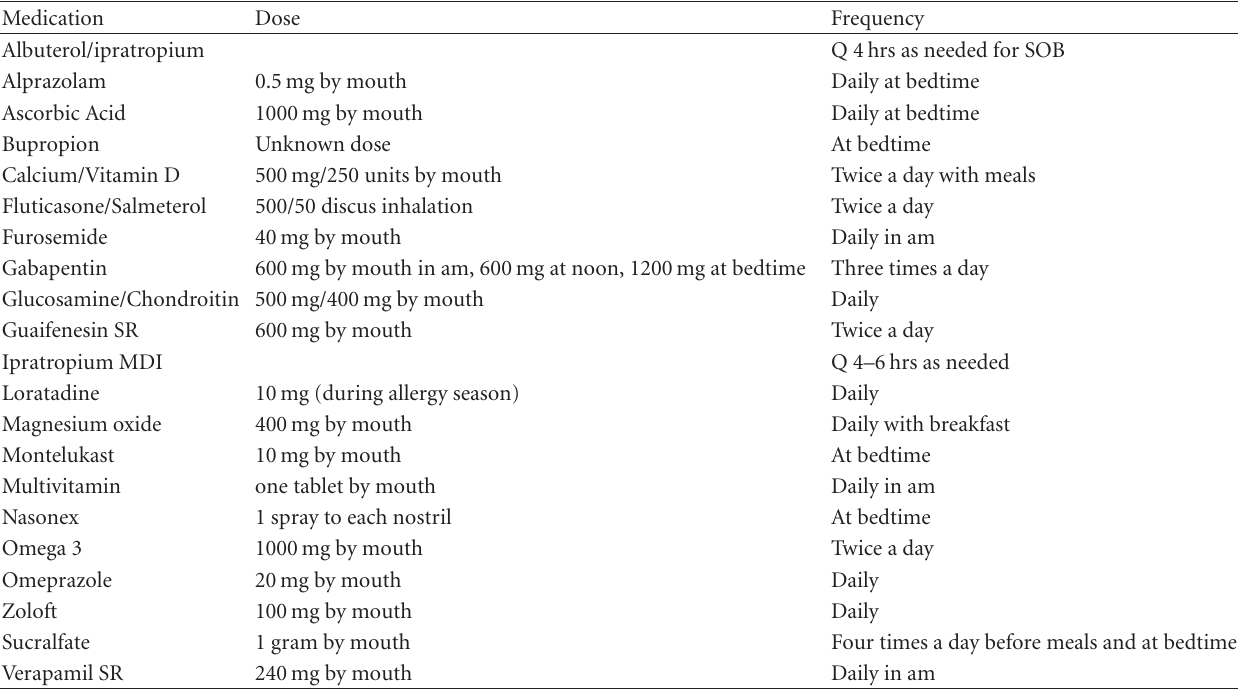
Table 2: Outpatient